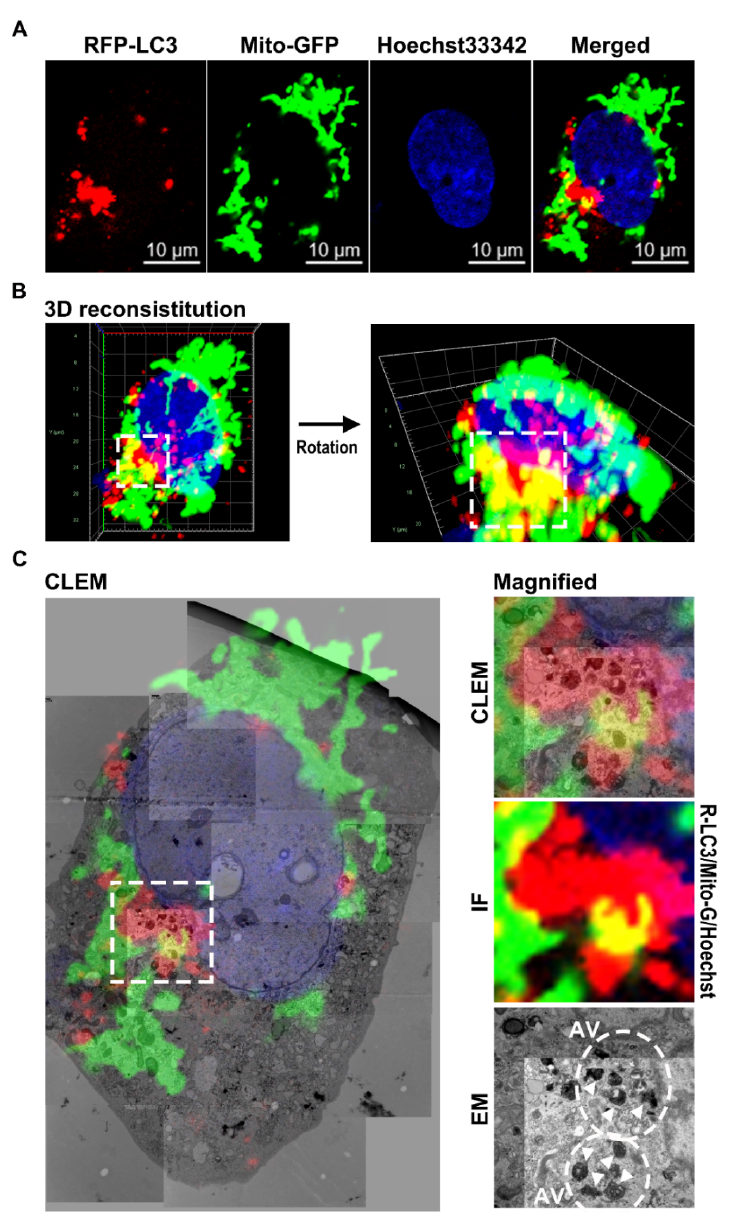
Figure 6. Correlative light and electron microscopy (CLEM) ultrastructural analysis of mitochondrial engulfment during autophagy in baicalein-treated cells: ( A ) Huh7/RFP-LC3/Mito-GFP cells were treated with 0.5 mM baicalein and observed with confocal microscopy. ( B ) Images from dif- ferent Z-stack positions were assembled, and a deconvolution 3-D structure was created as de- scribed in “Materials and Methods” (left panel). The rotated image of this 3-D structure is shown in the right panel. The white dashed box shows the sequestration of Mito-GFP within an area with RFP-LC3-labeled puncta. ( C ) The aligned images obtained by immunofluorescence (IF) and electron microscopy (EM) in CLEM are shown in the left panel. The magnified images in the right panel show the enlargement of the area in the white dashed box of the left panel. The white dashed circles and white arrowheads indicate autophagic vacuoles (AV) and engulfed mitochondria, respectively.